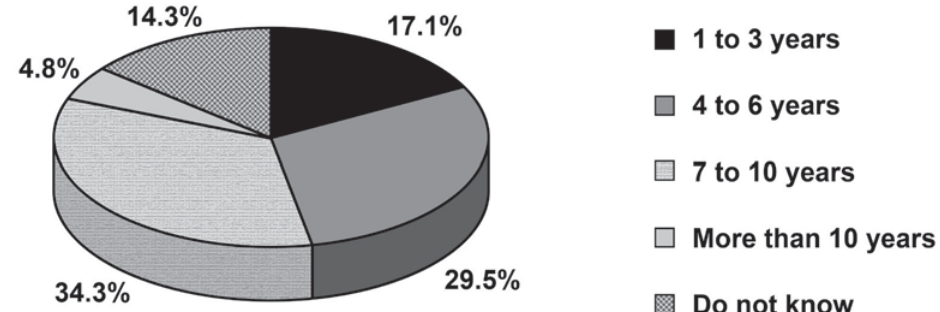
FIGURE 5- Percentage distribution of responses to the question “For how long has the ART approach been taught”?